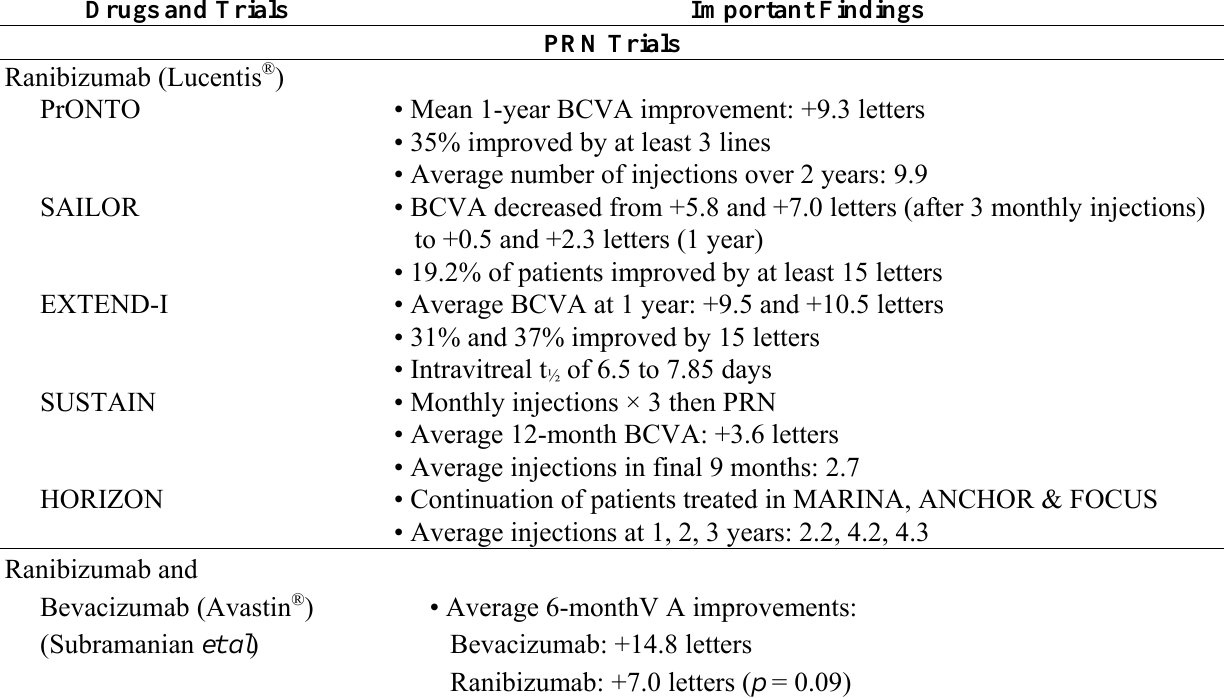
Table 2. Important trials supporting individualized therapy—as-needed and treat and extend—for the treatment of neovascular age-related macular degeneration are listed. Important design characteristics and top-end results are included. BCVA = best corrected visual acuity; CNVM = choroidal neovascularization; PDT = photodynamic therapy; wk = week; PRN = as